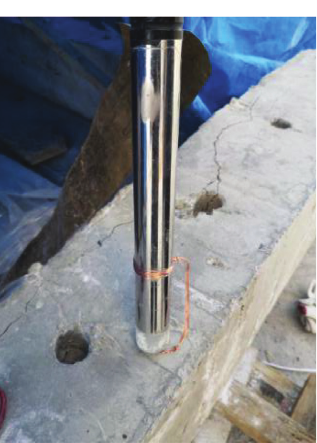
Figure 3: The discharge